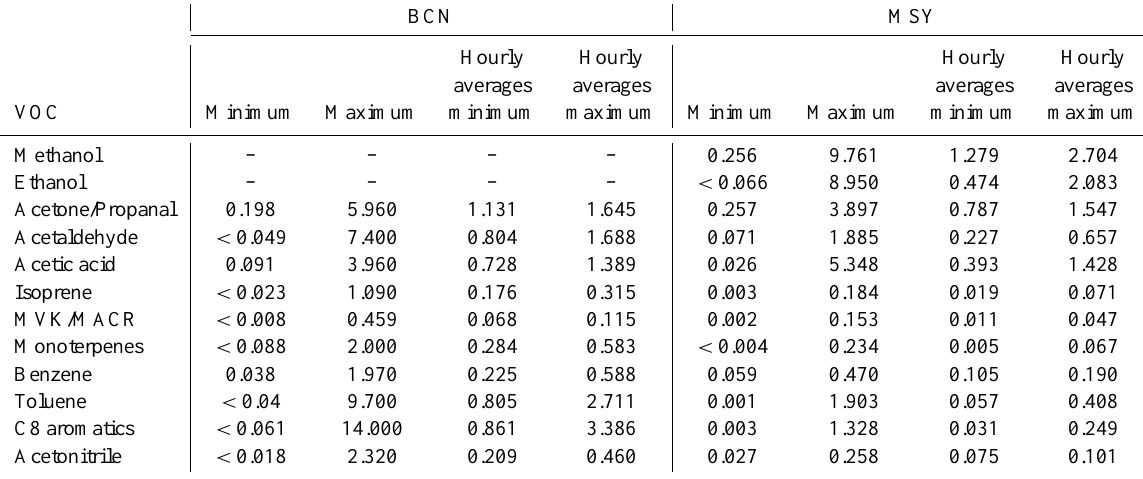
Table 2. Minimum and maximum VOC mixing ratios (ppbv) recorded at BCN and MSY stations during the winter campaign. These numbers correspond to the data displayed in Fig. 3. The data for MSY were previously reported in Seco et al. (2011b).